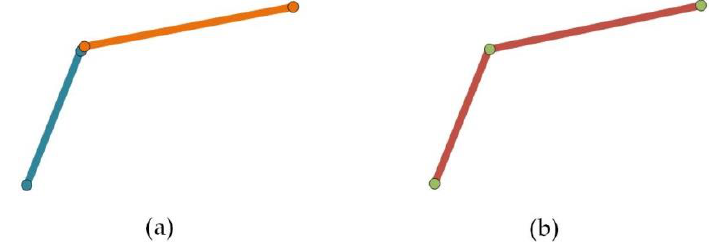
Figure 10. Polyline of the hole symbol: ( a ) discrete line segments and ( b ) topological reconstruction.